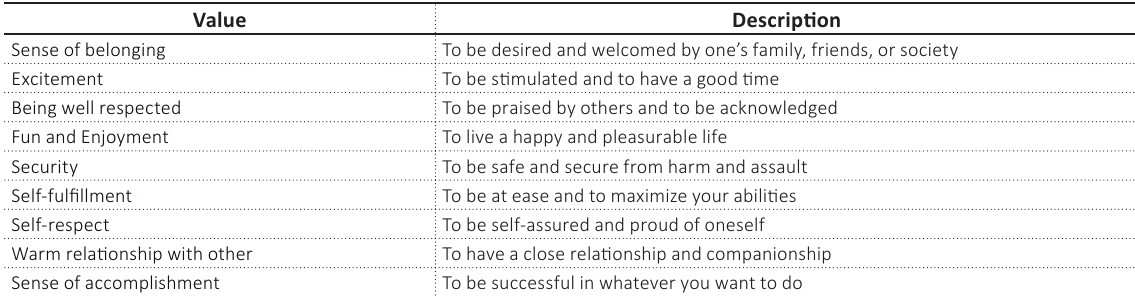
Table 1. Kahle’s (1986) List of Values